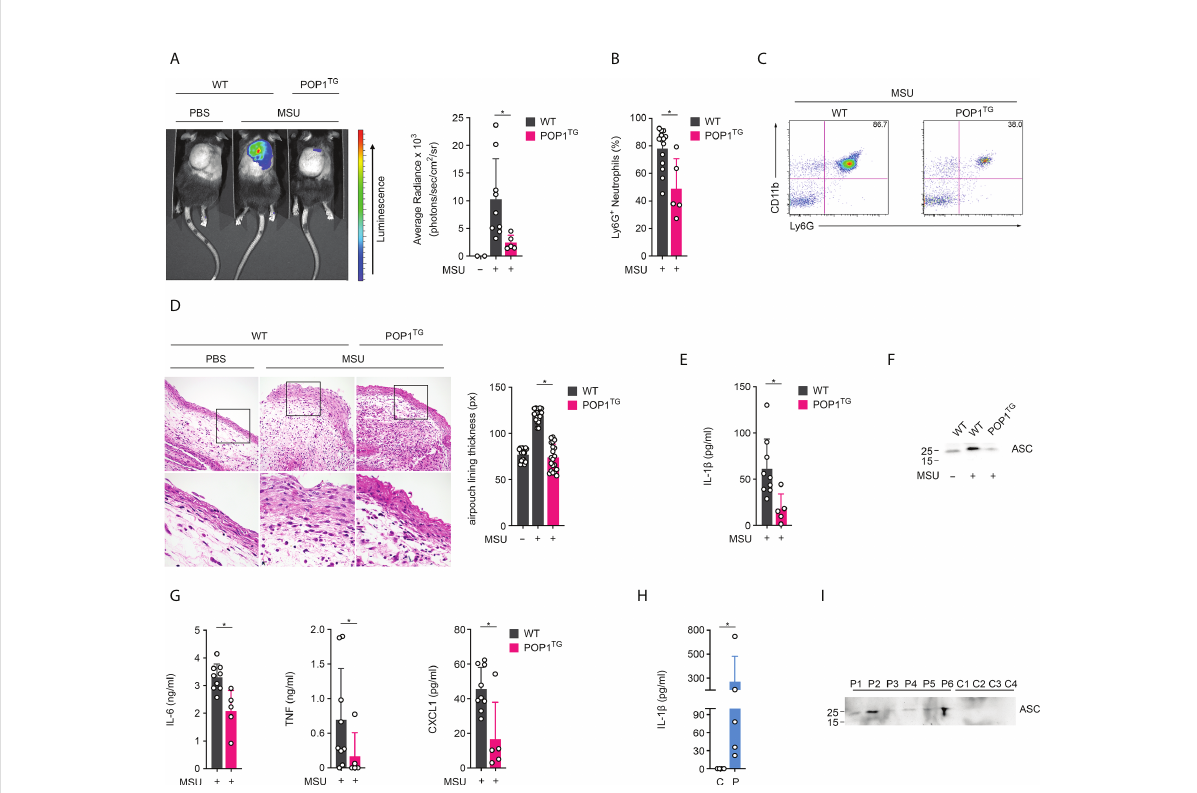
FIGURE 1 POP1 ameliorates MSU-induced in fl ammation in mice. (A) In vivo imaging of MPO activity correlating to MSU-induced neutrophil in fi ltration into subcutaneous air pouches 6h after MSU crystal injection in wild type (WT), and POP1 transgenic (POP1 TG ) mice (left) and average radiance (right) presented as photons/sec/cm 2 /sr (n = 3 - 9 ± s.d.). (B) Subcutaneous air pouch exudates were analyzed for CD11b + Ly6G + neutrophils by fl ow cytometry in mice injected with MSU crystals (n = 5 - 14 ± s.d.). (C) Representative example of a dot plot gating of CD11b and Ly6G stained cells